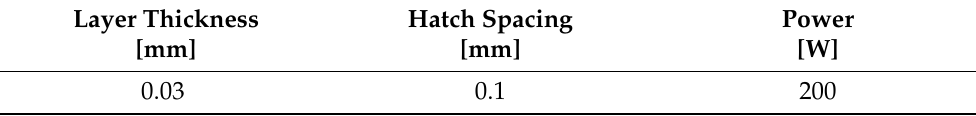
Table 1. SLM parameters